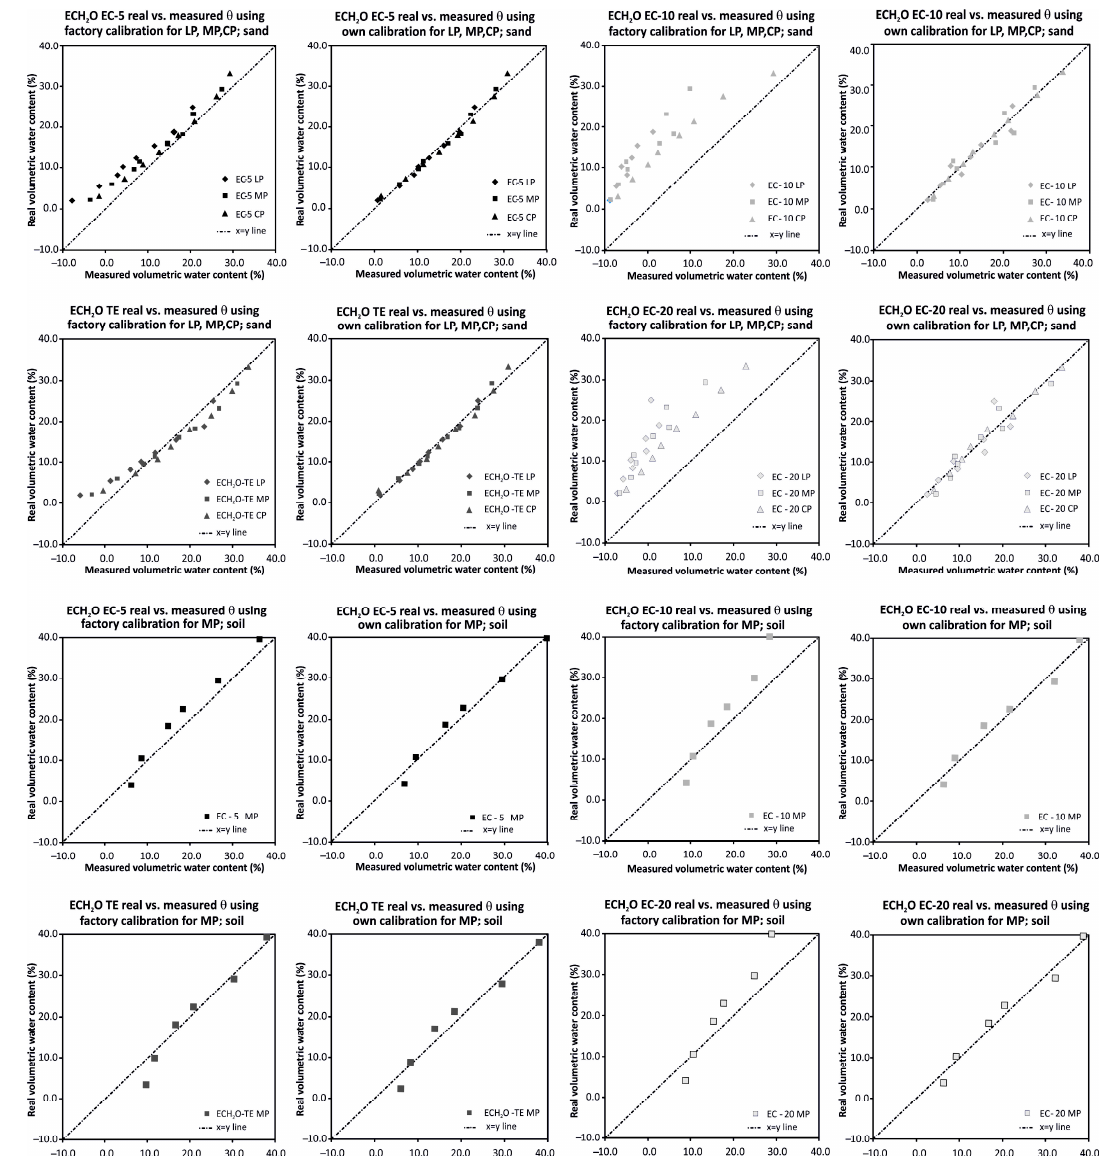
Figure 4. Graphical comparison of the real volumetric water contents obtained on the basis of gravimetric method and volumetric water contents measured by the sensors from the ECH 2 O family using factory and our own linear calibration equations.